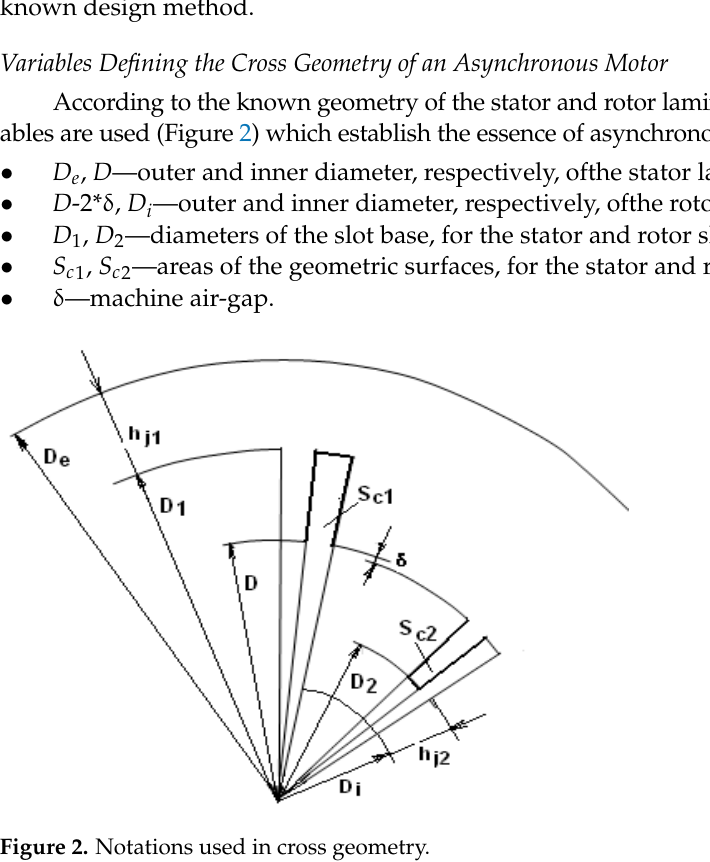
Figure 2. Notations used in cross geometry.